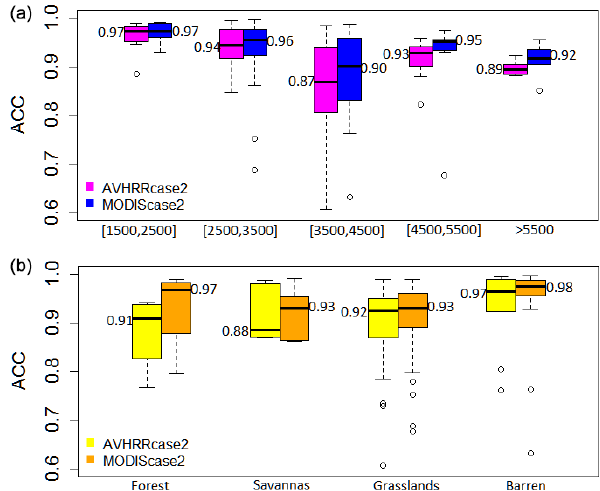
Figure 8. Boxplots of ACC from the direct comparison with in situ site observations over different elevation regions (a) and land-cover types (b) for AVHRR raw and MODIS snow data.